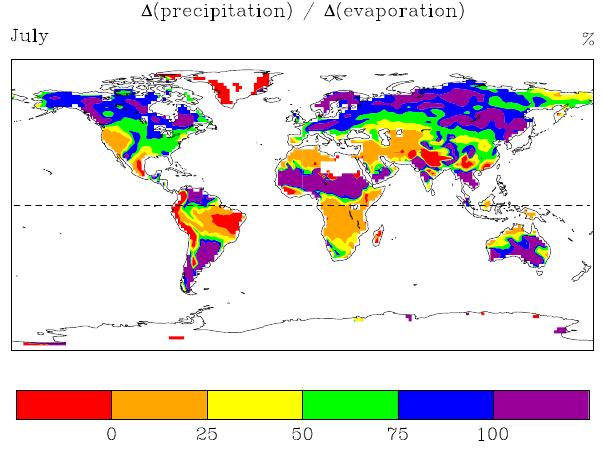
Fig. 10. The response of precipitation in relation to the im- posed evaporation decrease ( P DRY − P REF − , %) in July. Note that REF 1E = − E REF and (P − E) DRY = P DRY because E DRY =0. Violet indicates overcompensation (the land becomes a weaker moisture sink; P DRY < ( P − E) REF ), blue, green, yellow and orange indi- cate incomplete compensation (precipitation still decreases, but the land becomes a stronger moisture sink or weaker moisture source; ( P − E) REF <P DRY <P REF ), and red indicates an amplification of the effect from the evaporation decrease (precipitation increases and thus adds to the evaporation decrease; P DRY >P REF ). Continental regions with negative evaporation (=dew) in the REF experiment are left white. See Fig. S8 in the Supplement for